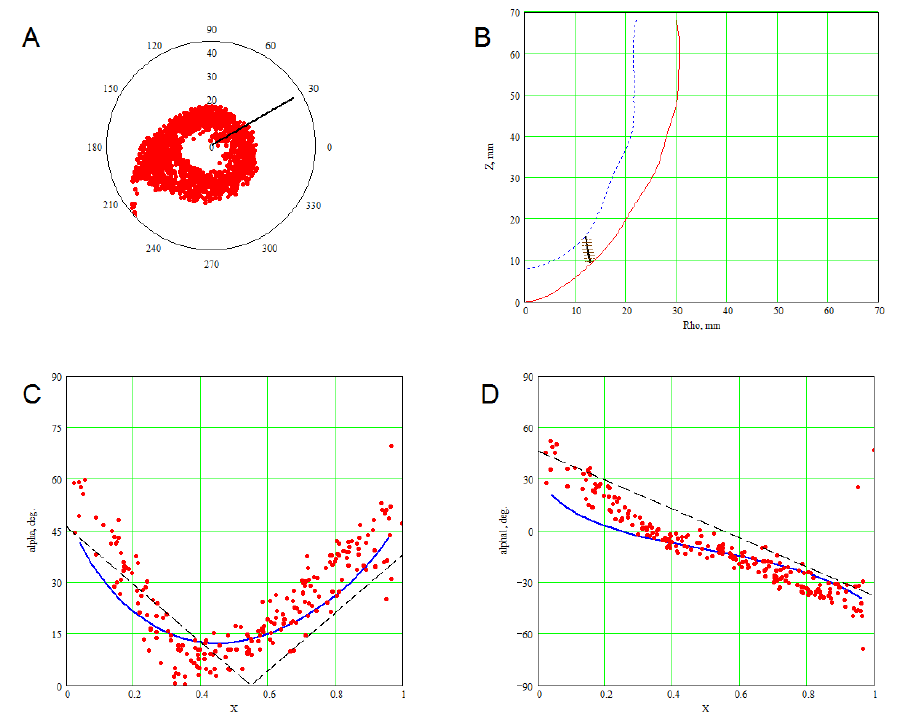
Figure 9. Fiber angles in the model and experimental data. The LV free wall in the apical area ( ψ = 60 ◦ ) is shown. The conventional signs are the same as in Figure